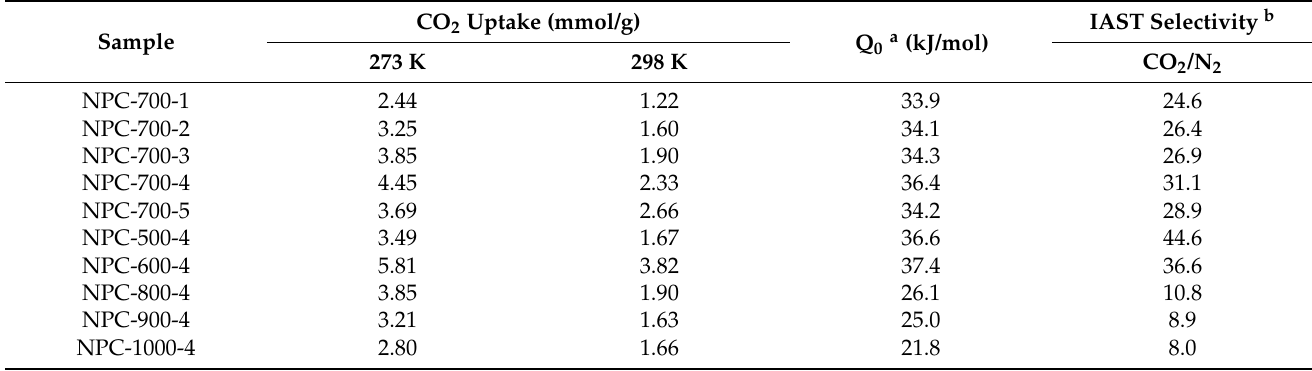
Figure 8. CO 2 adsorption–desorption isotherms at 273 K and 298 K for NPC-700-x ( a , b ) and NPC-y-4 ( c , d ). Table 3. CO 2 adsorption capacities, limiting adsorption enthalpies at zero coverage, and CO 2 /N 2 selectivities of NPC-700-x and NPC-y-4.